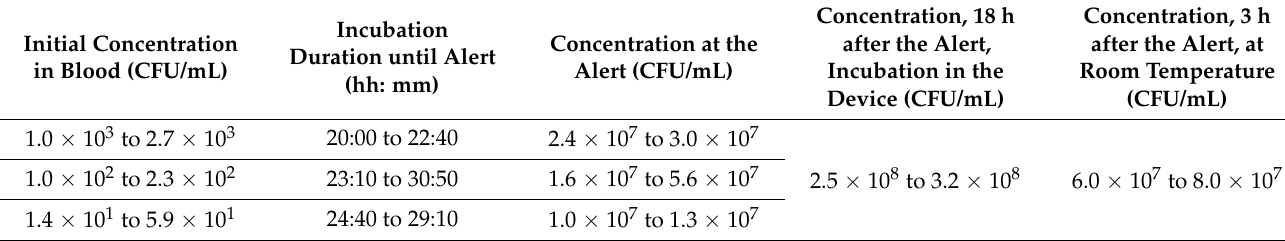
Table 9. Characterization of Y. pestis growth in blood culture vials.